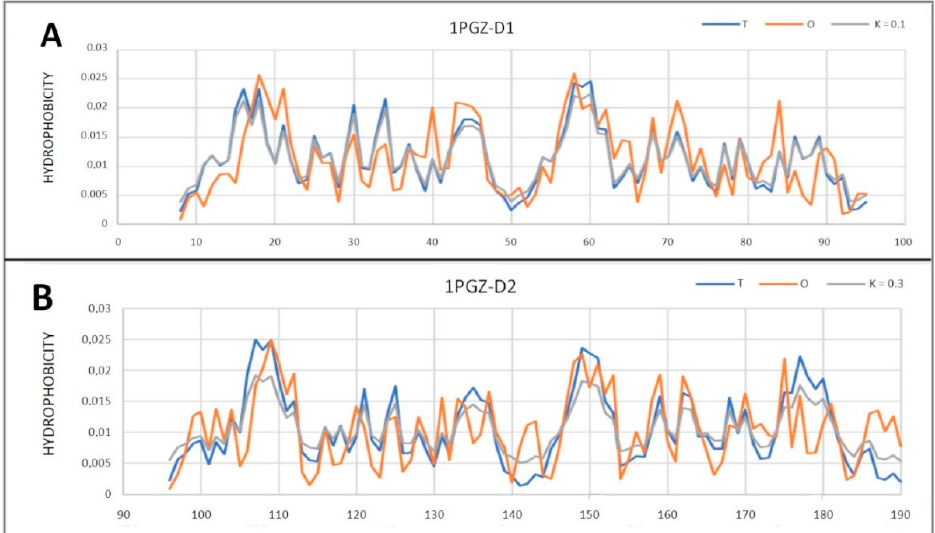
Figure 20. T, O and M profiles for the reference protein (in relation to 7BX7) of the hnrnpa family with PDB ID 1PGZ. ( A ) Domain 1; ( B ) domain 2. Domain 1; ( B ) domain